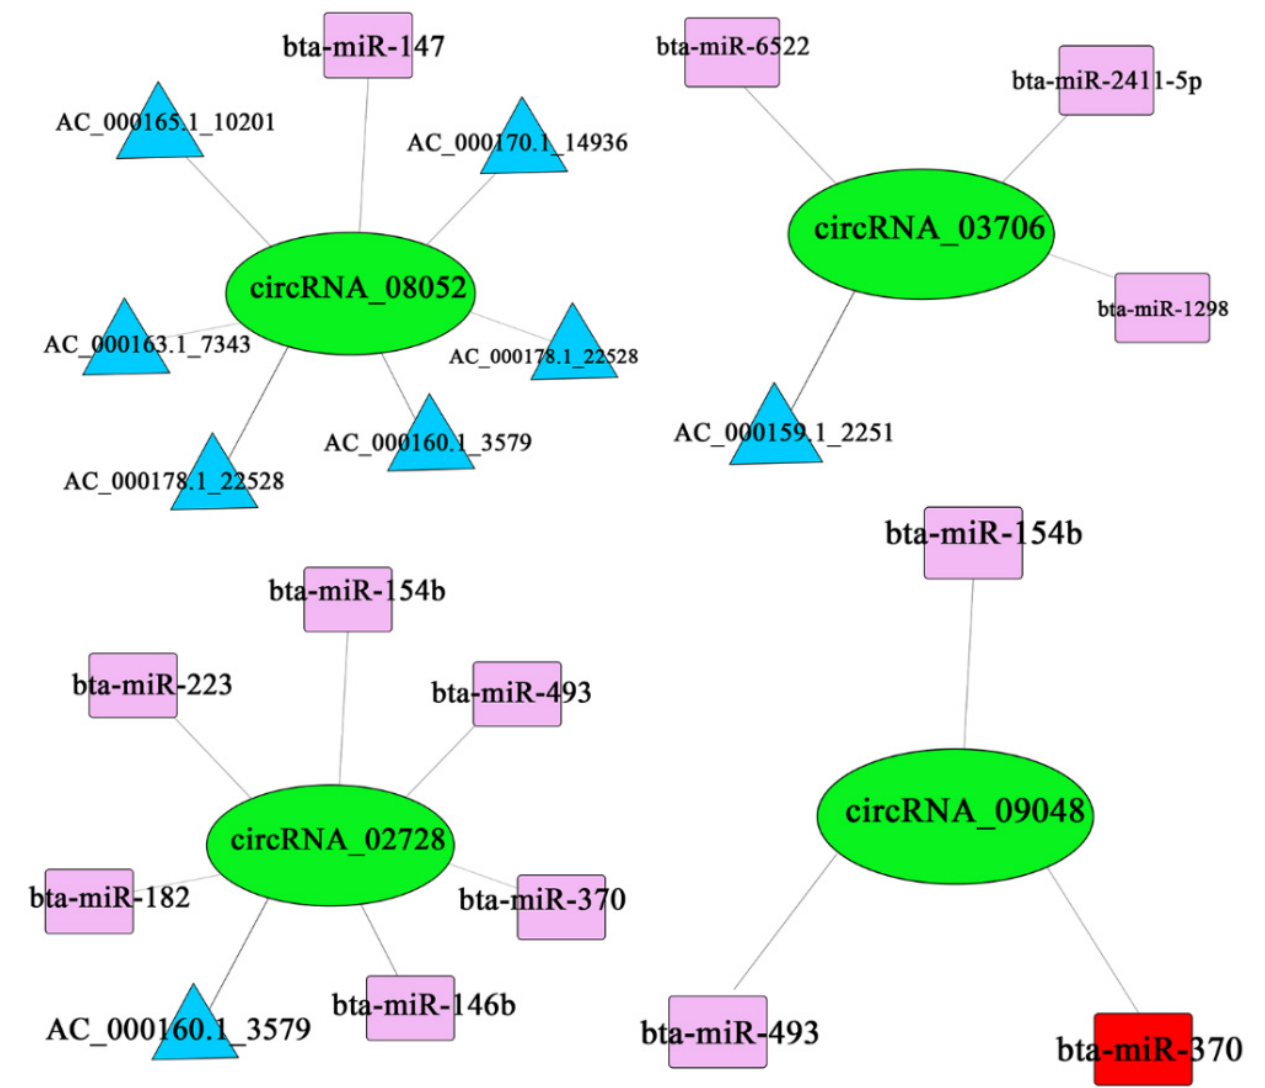
Figure 7. Four-network regulation of mRNA–circRNA–miRNA.